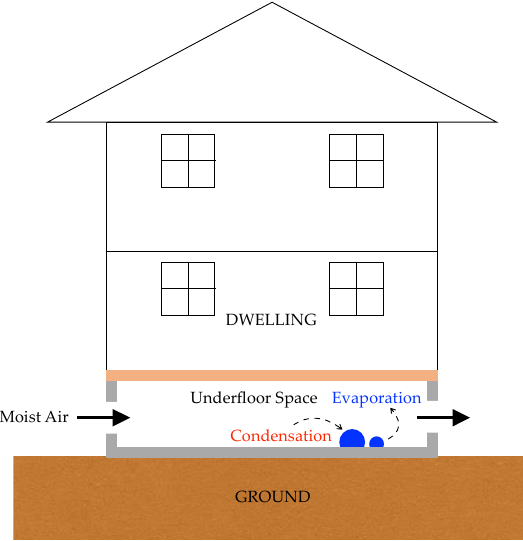
Figure 1. Underfloor ventilation in a Japanese detached house.